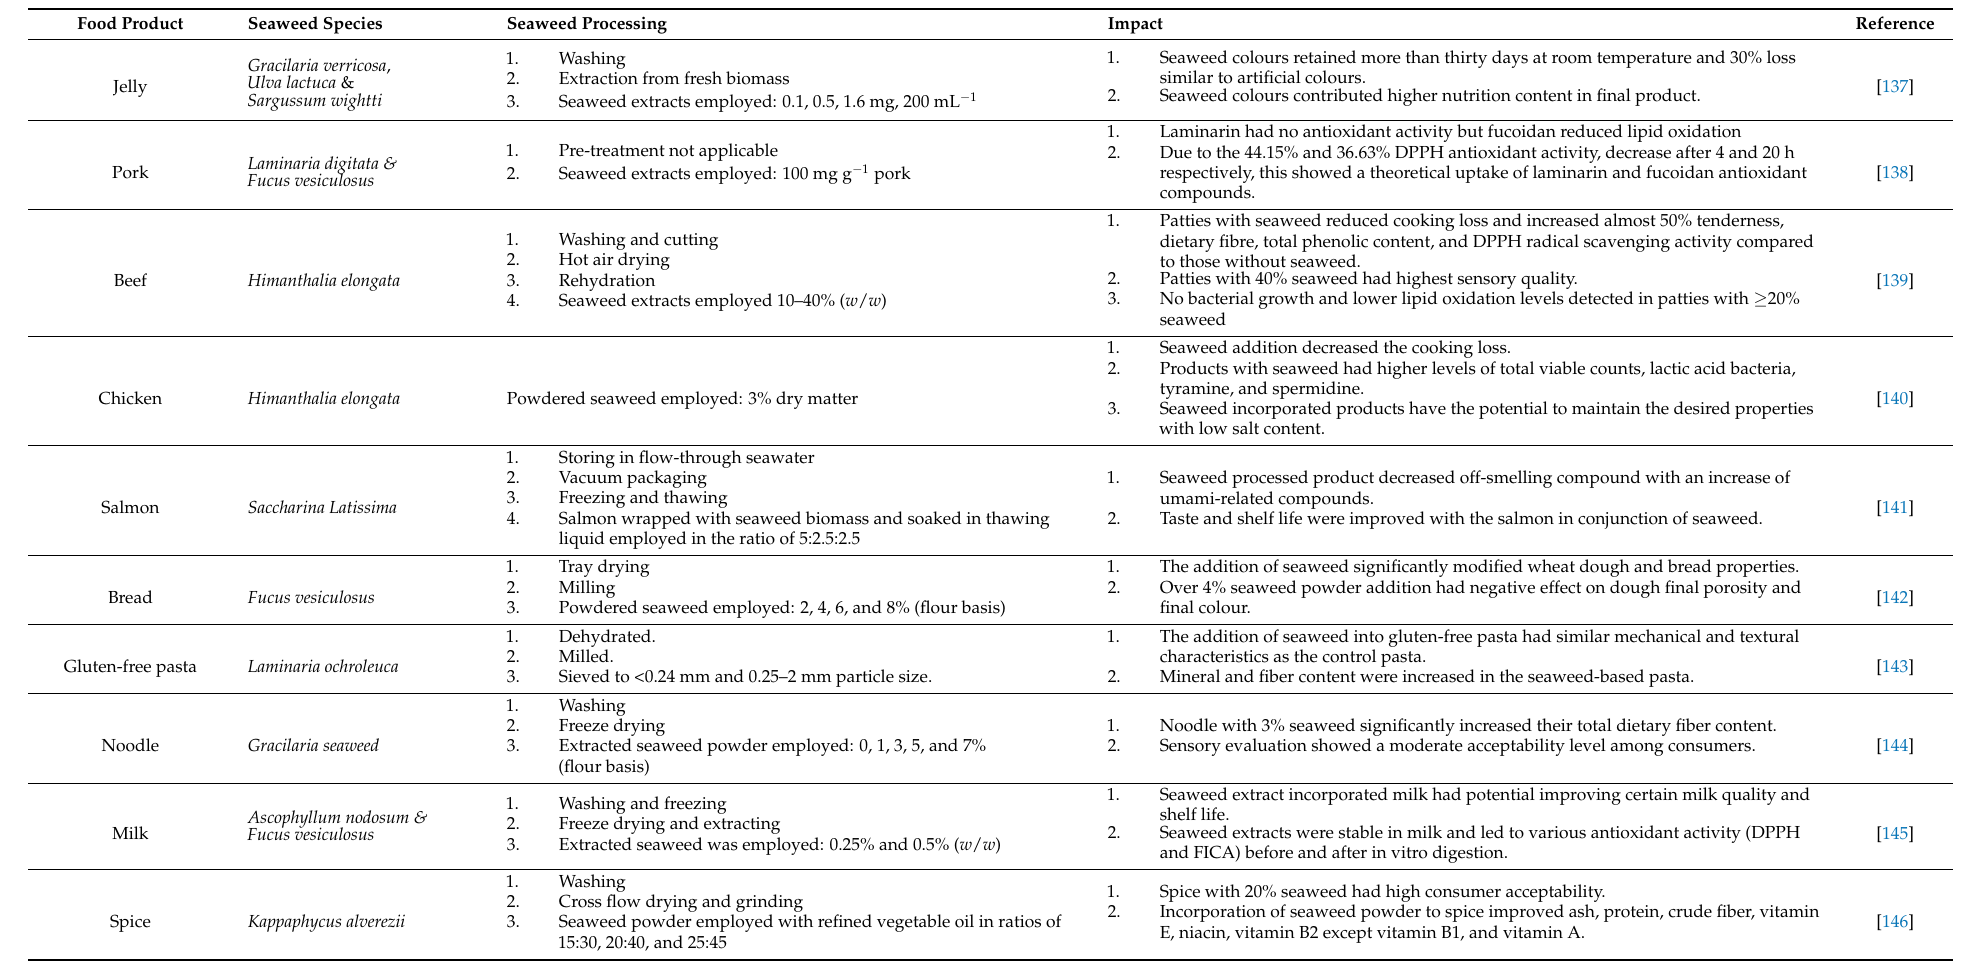
Table 5. Impact of seaweeds addition on food properties, adapted with permission from [93]. 2021 Zhu et